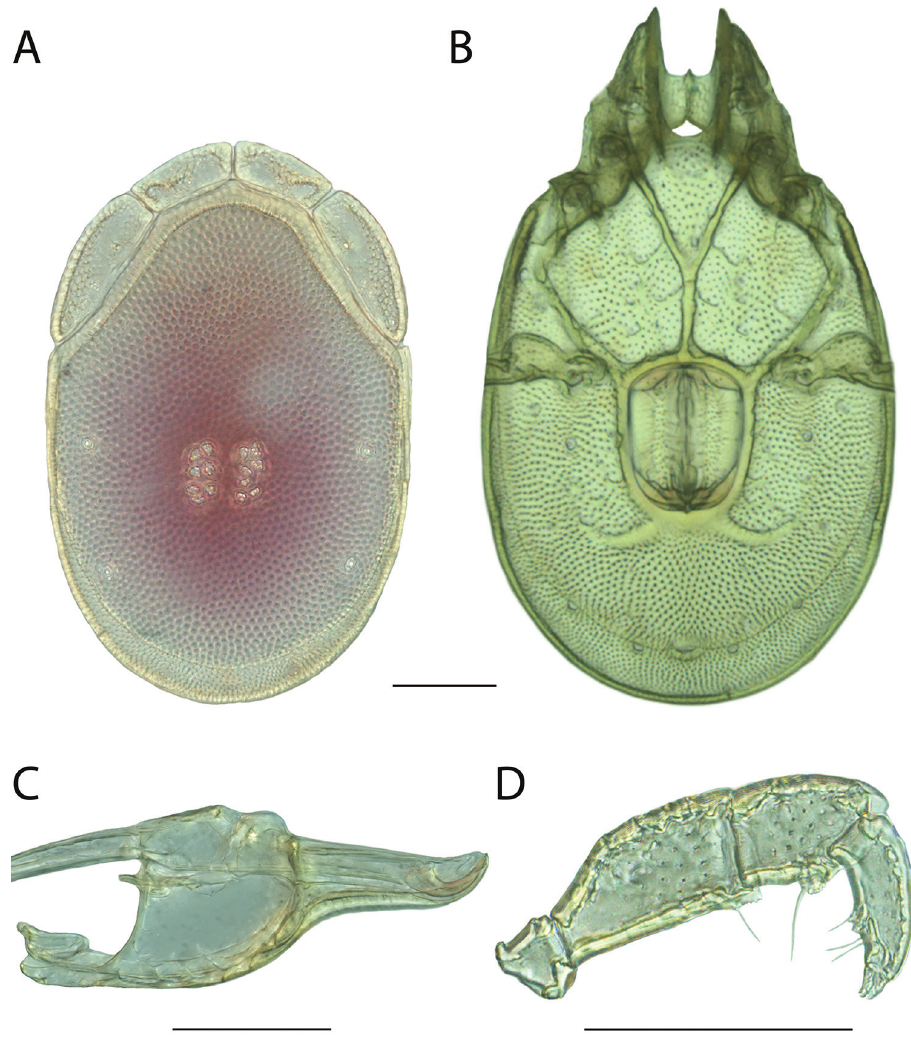
Figure 227. Torrenticola rockyensis sp. n. male: A dorsal plates B venter (legs removed) C subcapitulum D pedipalp (setae not accurately depicted). Scale = 100 µm. Dgl-4 255–285 (280)). Dorsal plate proportions: dorsum length/width